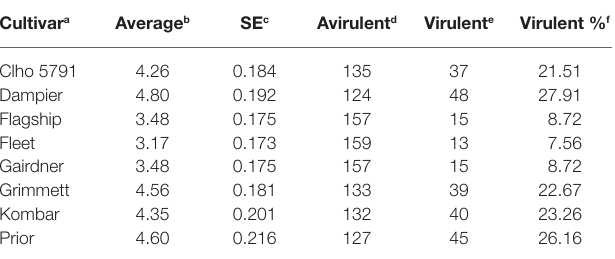
TABLE 1 | Disease reaction scores for the eight barley cultivars/lines used for QTL analysis and virulence percentage of the hybrid population for each barley cultivar/line.